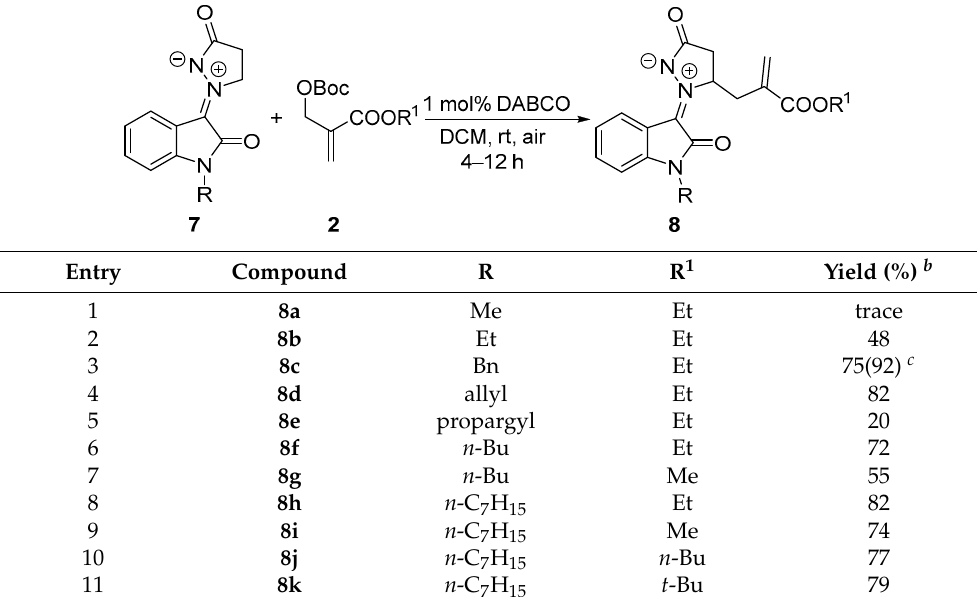
Table 4. Synthesis of N , β -allylated products 8 from N -substituted isatin N , N ′ -cyclic azomethine imine 6 and MBH carbonates 2 a .